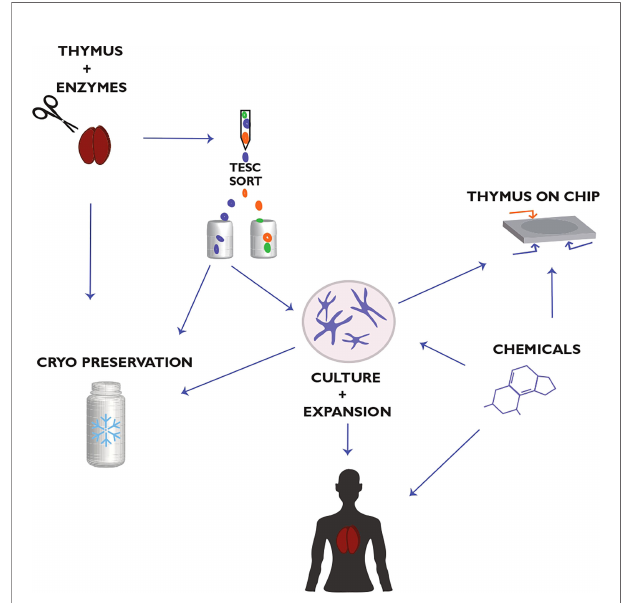
FIGURE 3 | Thymic epithelial stem cell (TESC)-based strategy for thymus regeneration with small chemical compounds (SCC). This strategy proposes the collection, preparation, and cryopreservation of primary thymic tissue and TESC-enriched cell samples. These thymic samples are used further to select TESC-speci fi c SCC that can regulate the differentiation and proliferation of human TESCs and support their clonal expansion. The selected SCC are tested also for supporting thymic tissue growth in vitro as well as for reconstitution of thymic function in terms of differentiation, maturation, and tolerance of autologous T cells. The use of micro fl uidic chips in combination with human 3D thymic organ cultures (Thymus-on-Chip devices) to assess SCC speci fi city and toxicity is essential to accelerate drug development for thymus-compromised patients. Actual challenges are optimizing the thymectomy procedure in patients to preserve a thymic fragment for consequent postsurgical thymus regeneration and the quality life monitoring of thymectomized patients concerning their resistance to infections, allergies, autoimmune, oncological, and other diseases associated with the impaired thymic function. Modi fi ed from Shichkin and Antica, 2020 (9); the article is licensed under a Creative Commons Attribution 4.0 International